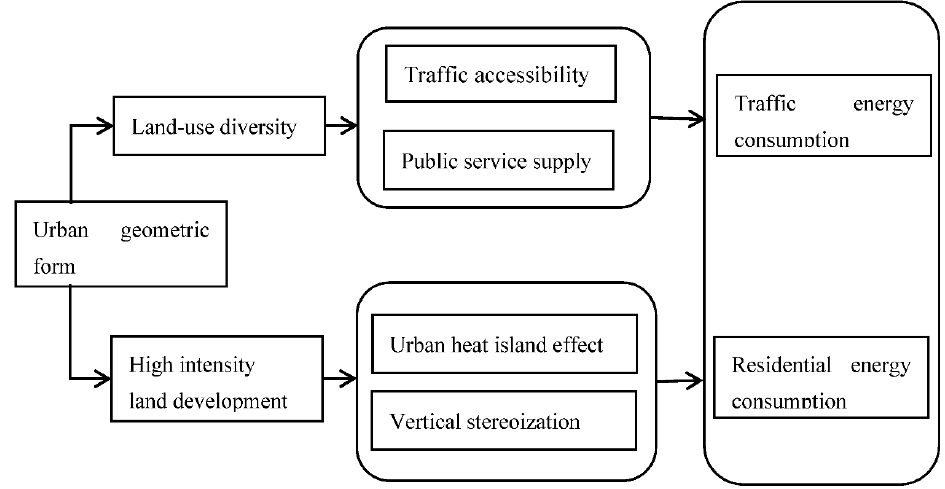
Figure 1. Mechanism of Urban Geometric form on Household Energy Consumption.